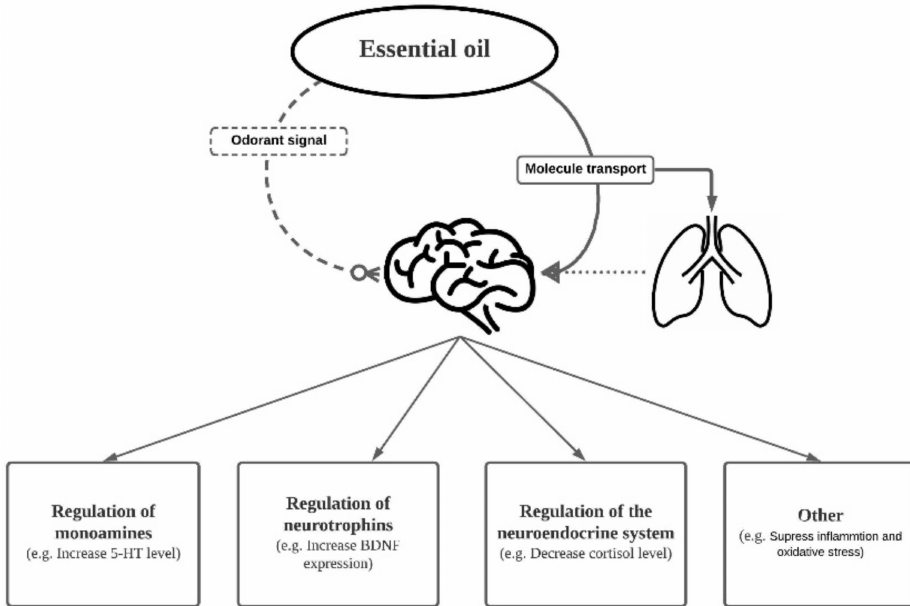
Figure 3. Summary of the EO delivery pathway in connection to the respiratory system and central nervous system. EO molecules exert an effect on mood disturbances via different possible routes, including regulation of monoamines, neurotrophic factors, and the neuroendocrine system, which are all potential mechanisms underlying the therapeutic